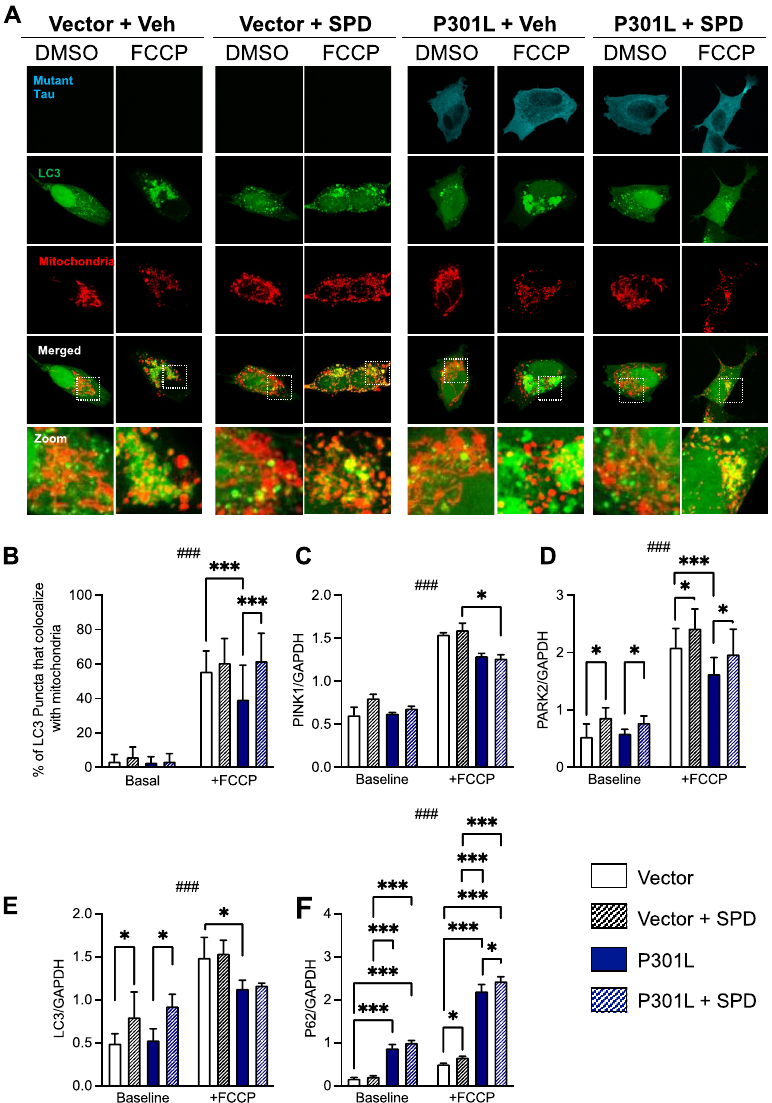
Figure 5. Effects of spermidine on mitophagy in P301L tau-expressing cells and control cells. ( A ) To assess the levels of basal and carbonyl cyanide p-trifluoro-methoxyphenyl hydrazone (FCCP)-induced mitophagy, P301L and vector cells were transfected with LC3-RFP (green) and then stained with mitotracker (red) to measure the colocalization of LC3 puncta with mitochondria. ( B ) In basal conditions, no significant effect of P301L tau on cellular mitophagy was observed. However, following stimulation with the protonophore FCCP, which induces mitophagy by collapsing the mitochondrial membrane potential, P301L cells exhibited significantly reduced mitophagy compared with con- trols. Spermidine (SPD) significantly increased mitophagy in P301L cells following FCCP treatment. ( C – F ) Impact of mutant tau and SPD on the mRNA level of proteins involved in mitophagy, namely PINK1 ( C ), PARK2 ( D ), LC3 ( E ) and P62 ( F ). * p < 0.05, *** p < 0.001; three-way ANOVA + post hoc Tukey’s multiple comparisons test, ### p < 0.001, three-way ANOVA baseline vs. FCCP. PINK1: PTEN-induced putative kinase 1; PARK2: Parkin; LC3: microtubule-associated protein 1A/1B-light chain 3; P62: